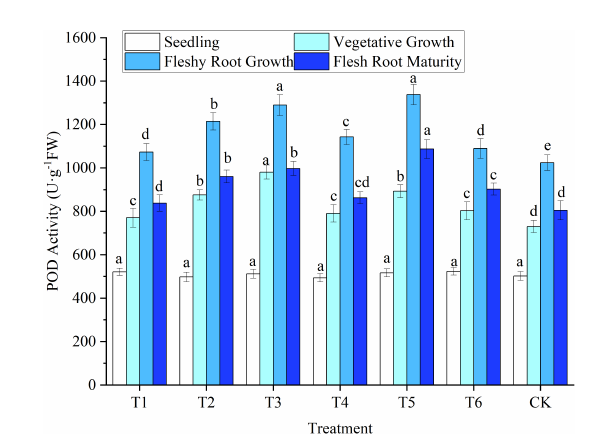
FIGURE 4 Response of proline in woad plants in different water de fi cits. Different lowercase letters in the same column mean the signi fi cant differences among treatments according to LSD ( P < 0.05). Data were presented as mean ± SE (n =